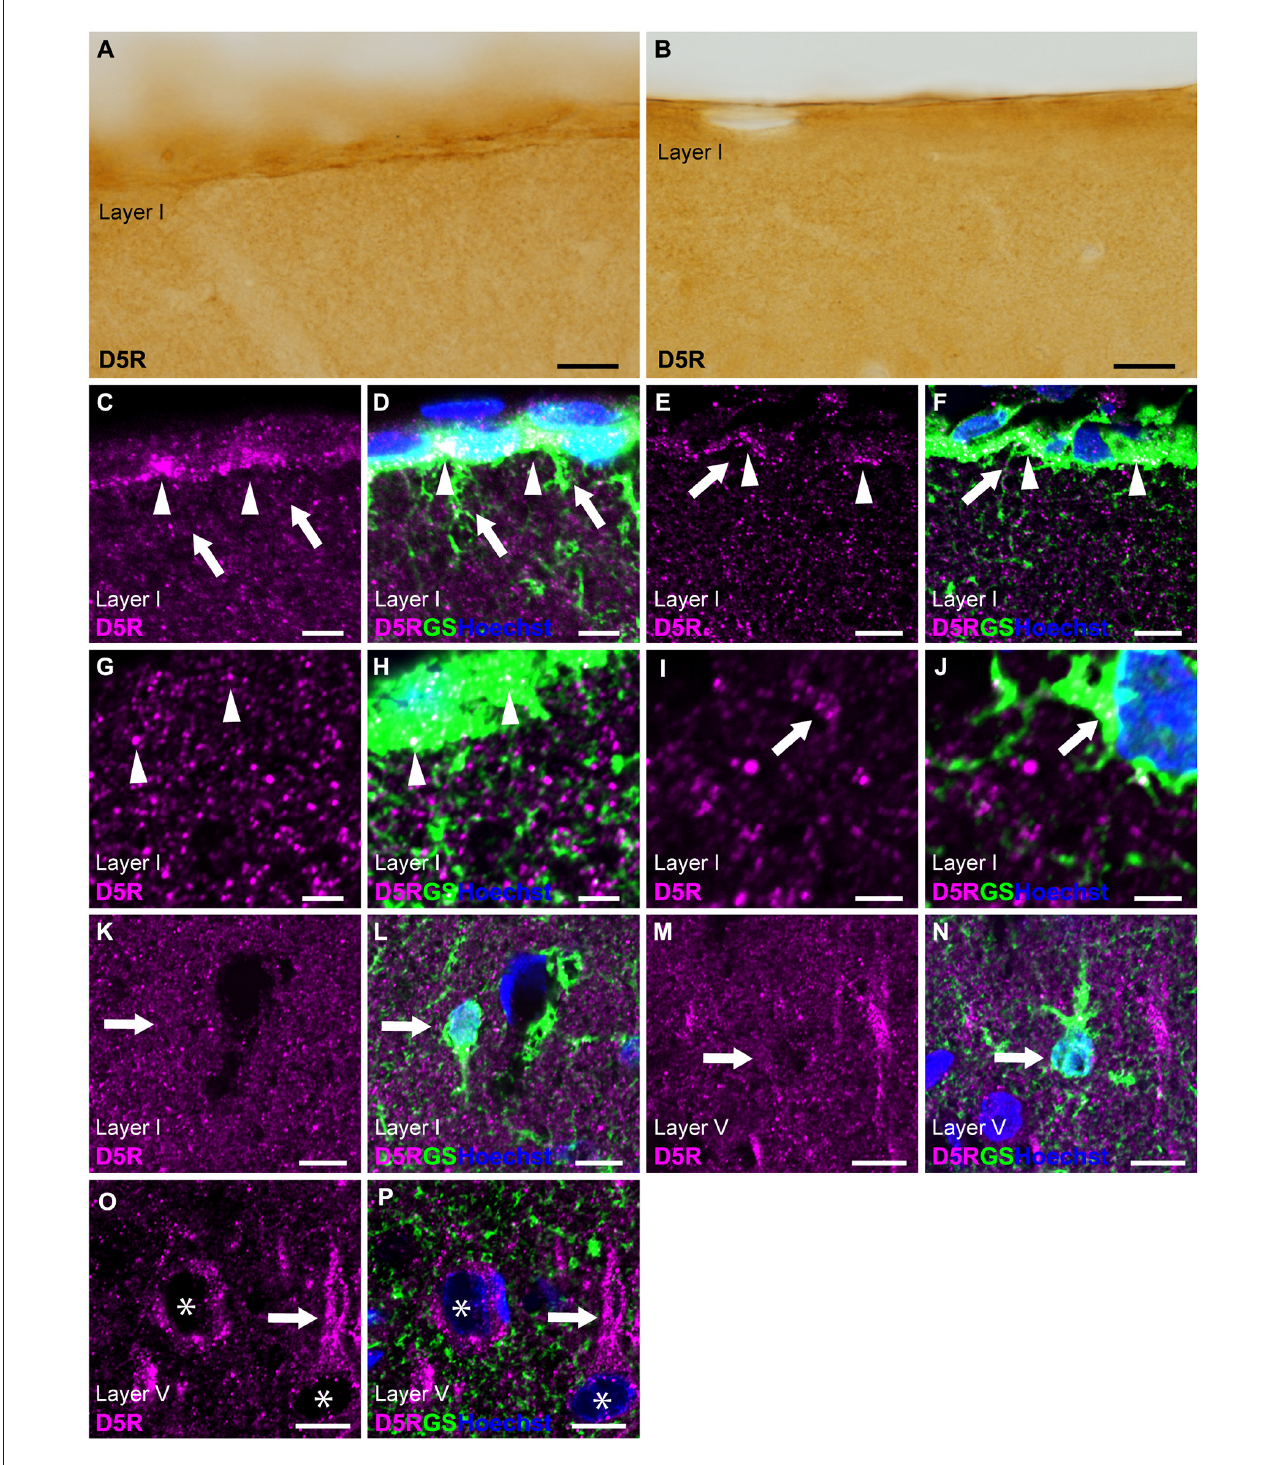
FIGURE5 D5R-immunoreactivity in astrocytes. (A,B) Moderate D5R-immunoreactivities of the cortical surface of the prelimbic (A) and somatosensory (B) areas. (C,D) Confocal imaging of double immunostaining for D5R (magenta) and GS (green) indicated D5R-immunoreactivities biased toward the parenchymal side within pial astrocytes (arrowheads) in the prelimbic area. Processes of pial astrocytes (arrows) had only a few D5R-immunoreactivities. (E,F) D5R-immunoreactivities in the parenchymal side within pial astrocytes (arrowheads) in the somatosensory area. Processes of pial astrocytes (arrows) had only a few D5R-immunoreactivities. (G,H) In layer I of the primary motor area, astrocytes showed immunoreactivities for D5R (arrowheads). Strong and granular immunoreactivities for D5R were observed (magenta), which were in close vicinity of GS-positive structure (green), but not overlapped. (I,J) Confocal imaging of double immunostaining for D5R (magenta) and GS (green) indicated D5R-immunoreactivities in layer I astrocytes (arrows) in the primary motor area. (K,L) In layer I of the primary motor area, GS-positive astrocytes showed weak immunoreactivities for D5R (arrows). (M,N) In layer V of the primary motor area, GS-positive protoplasmic astrocytes (arrows) showed weak D5R-immunoreactivities. (O,P) In layer V of the primary motor area, strong D5R-immunoreactivities were observed in pyramidal cell-like large cells (asterisks) and their processes (arrows). Nuclei were stained with Hoechst33342. Scale bars: 20 µ m (A,B) ; 10 µ m (C–F,K–P) ; 5 µ m (G–J)